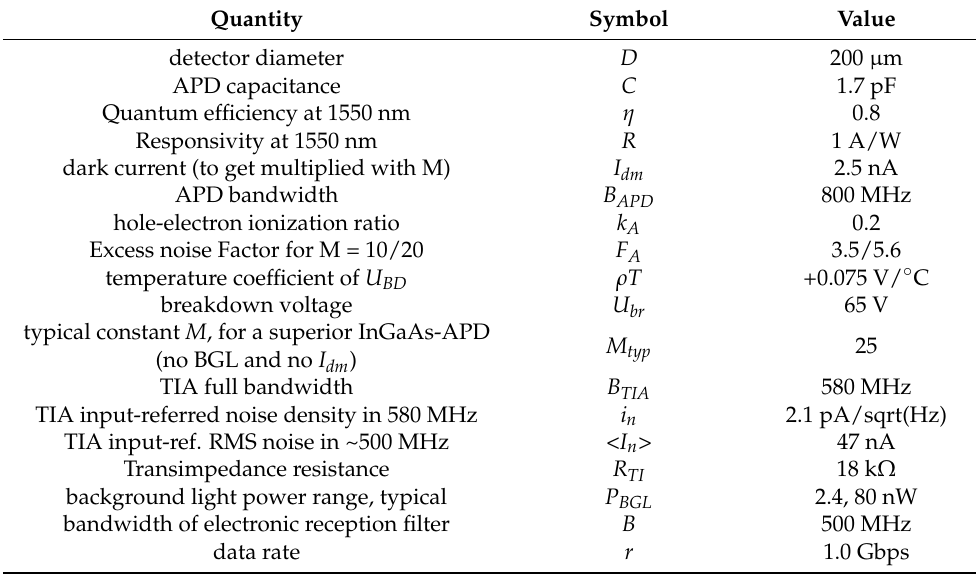
Table A1. Typical Values for a 1 Gbps APD